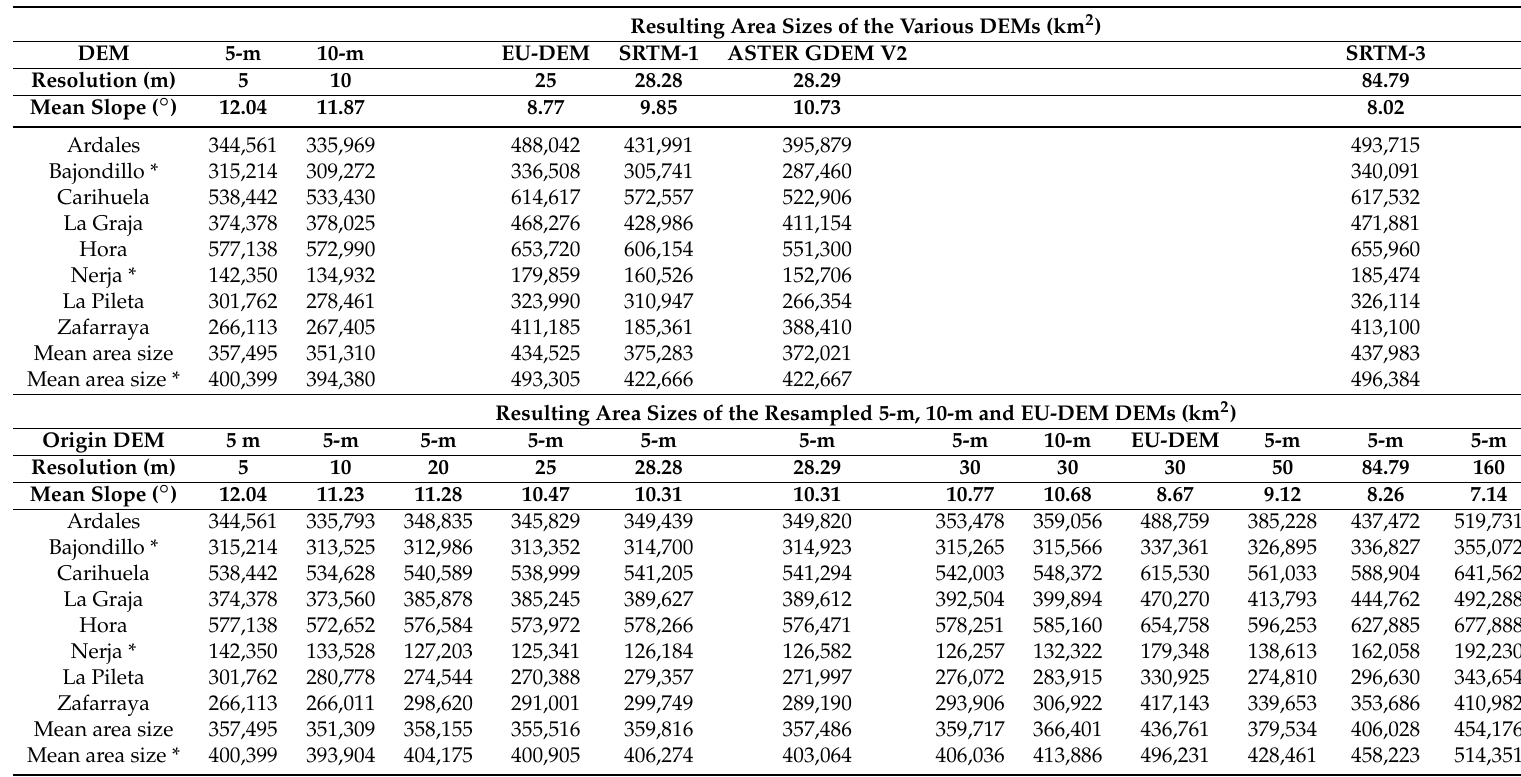
Table A1. Slope characteristics and resulting area sizes of 4-h site catchments calculated with the presented method. The method was applied to 8 prehistoric sites with the various DEMs and with resampled versions of the 5-m DEM as input data (lower section of the table). * = sites are located near the coast, and the associated area sizes are excluded in the calculation of the mean area